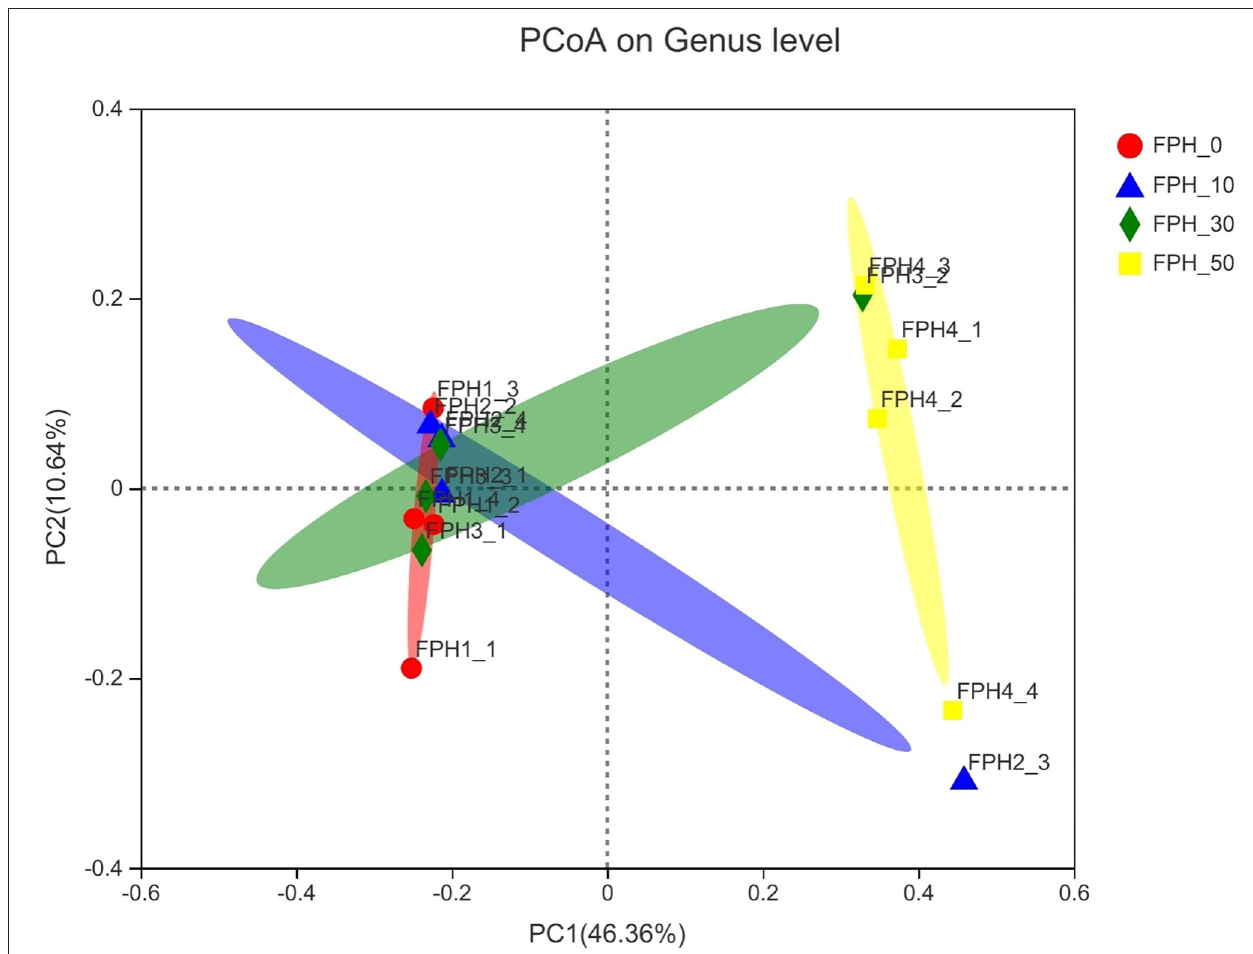
FIGURE 5 | Principal coordinate analysis (PCoA) analysis of the unweighted UniFrac scores of intestinal microflora of largemouth bass (Micropterus salmoides) fed the diets containing different supplementation levels of fish protein hydrolysate (FPH).